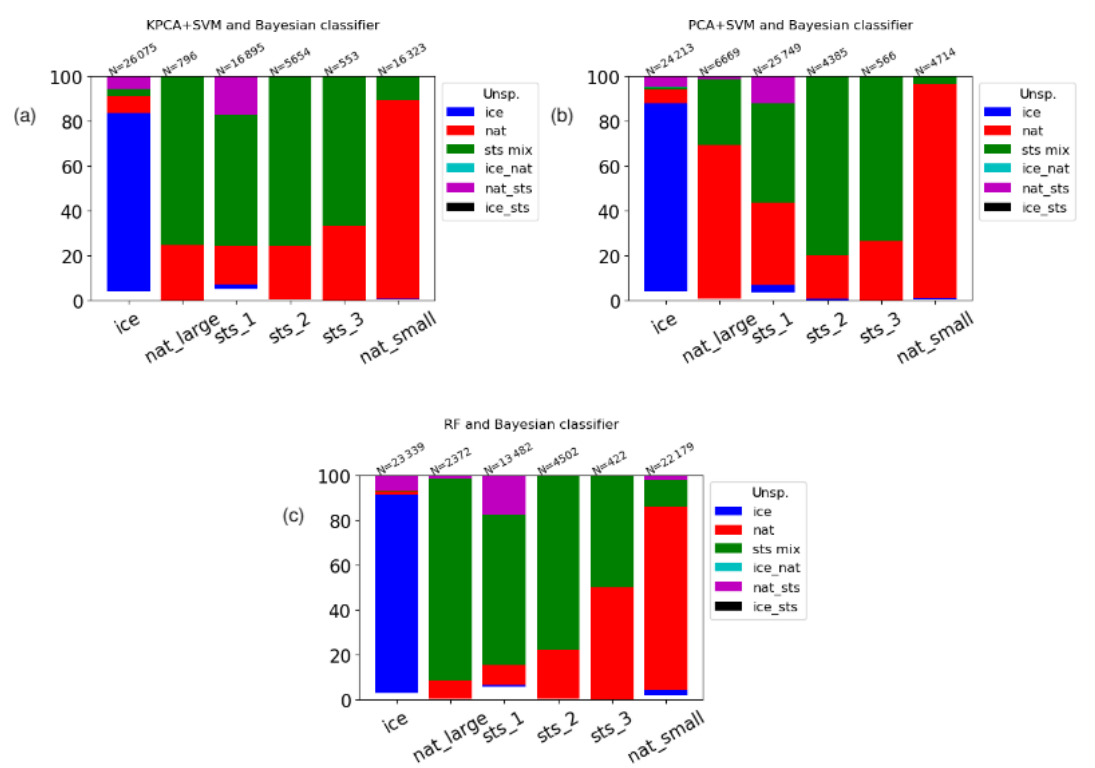
Figure 16. Intercomparison of ML and Bayesian classifiers for Southern Hemisphere winter (May to September 2009). Ticks on the x axis represent the classes of the KPCA + SVM classifier (a) , the PCA + SVM classifier (b) , and the RF classifier (c) . The y axis indicates the fraction of the classes as predicted by the Bayesian classifier. N is the number of samples belonging to each class of the ML